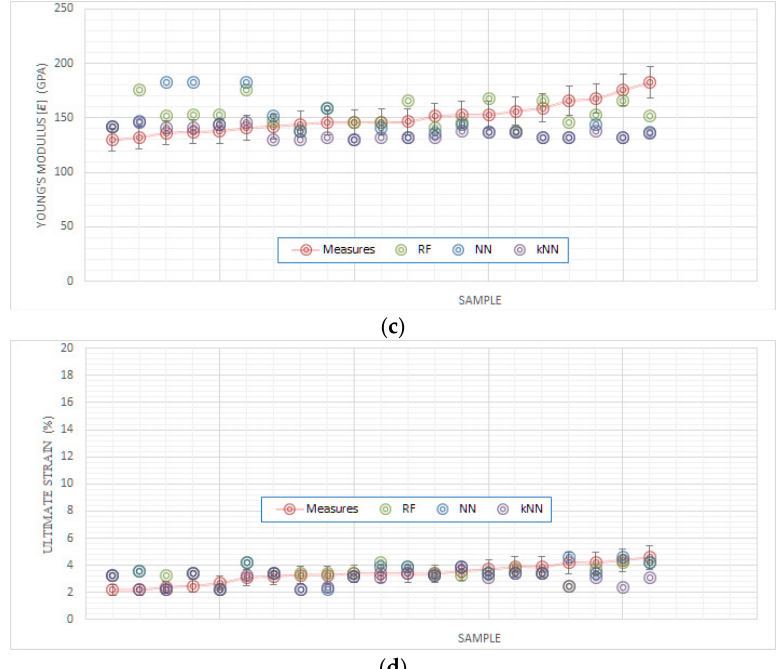
Figure 2. Metallurgical properties (( a ) Ultimate Tensile Strength (UTS), ( b ) Yield Strength (YS), ( c ) Ultimate Strain ( ε ), ( d ) Young’s modulus ( E )) in the case of Compacted Graphite Iron (CGI), as measured and predicted.